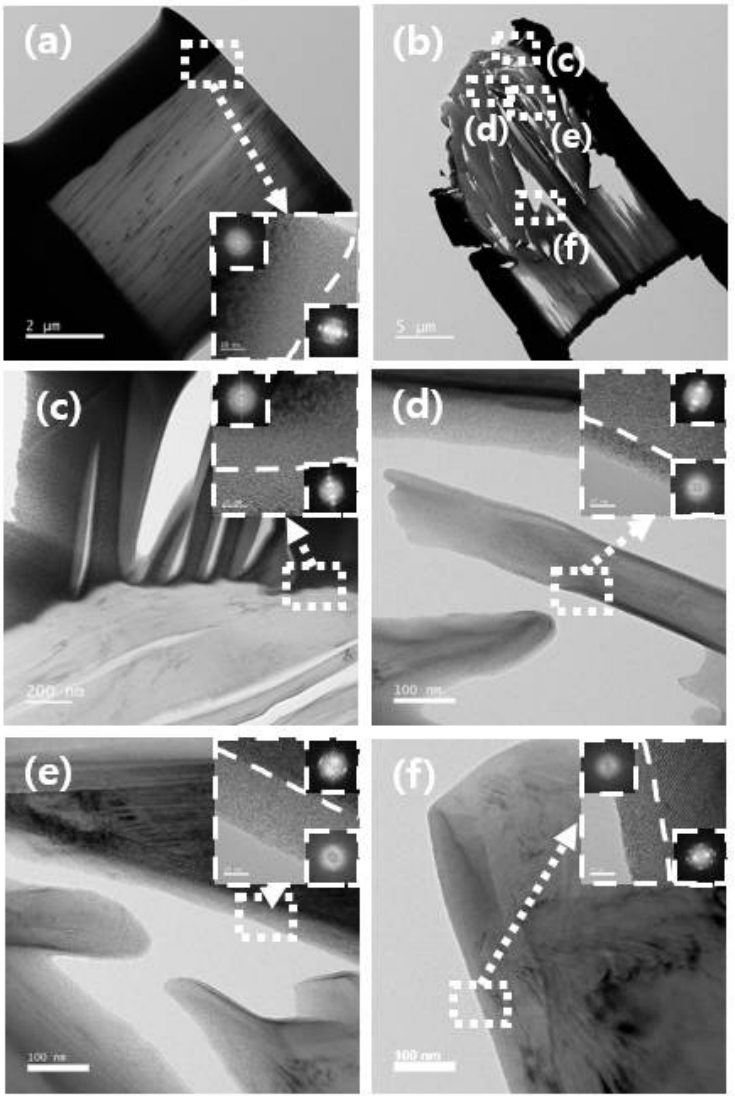
Figure 2. Cross-sectional transmission electron microscopy (TEM) image of AG and MNG particles: low-magnification TEM image of ( a ) AG, ( b ) MNG, and ( c – f ) High-resolution transmission electron microscopy(HRTEM) images of selected areas in Figure 2b. Inset represents enlarged image and diffraction pattern for dotted area of each fig- ures.